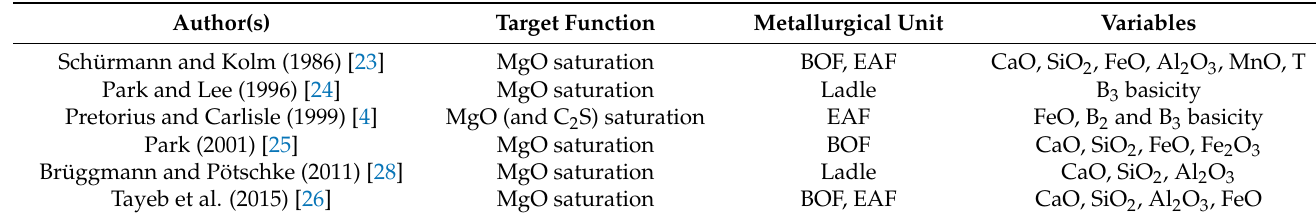
Table 1. Published models of MgO saturation of steelmaking